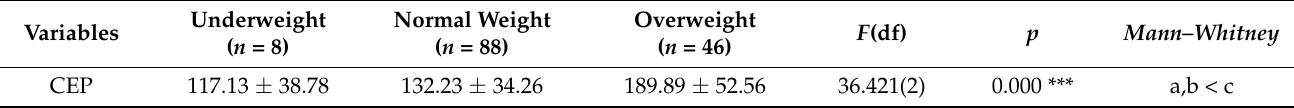
Table 5. Comparison of CEP by BMI.